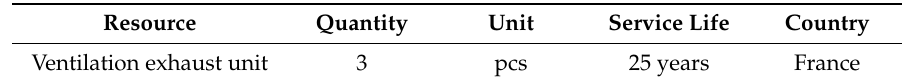
Table 2. As built dataset.